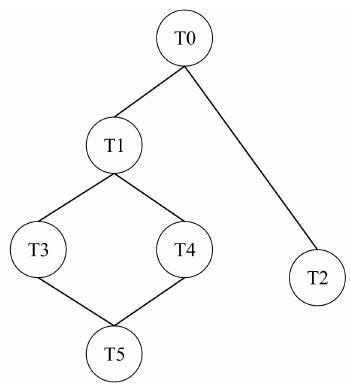
Figure 4. Topology